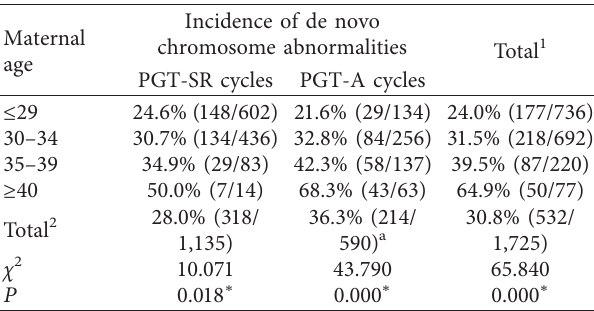
Table 2: Incidence of de novo chromosome abnormalities at different